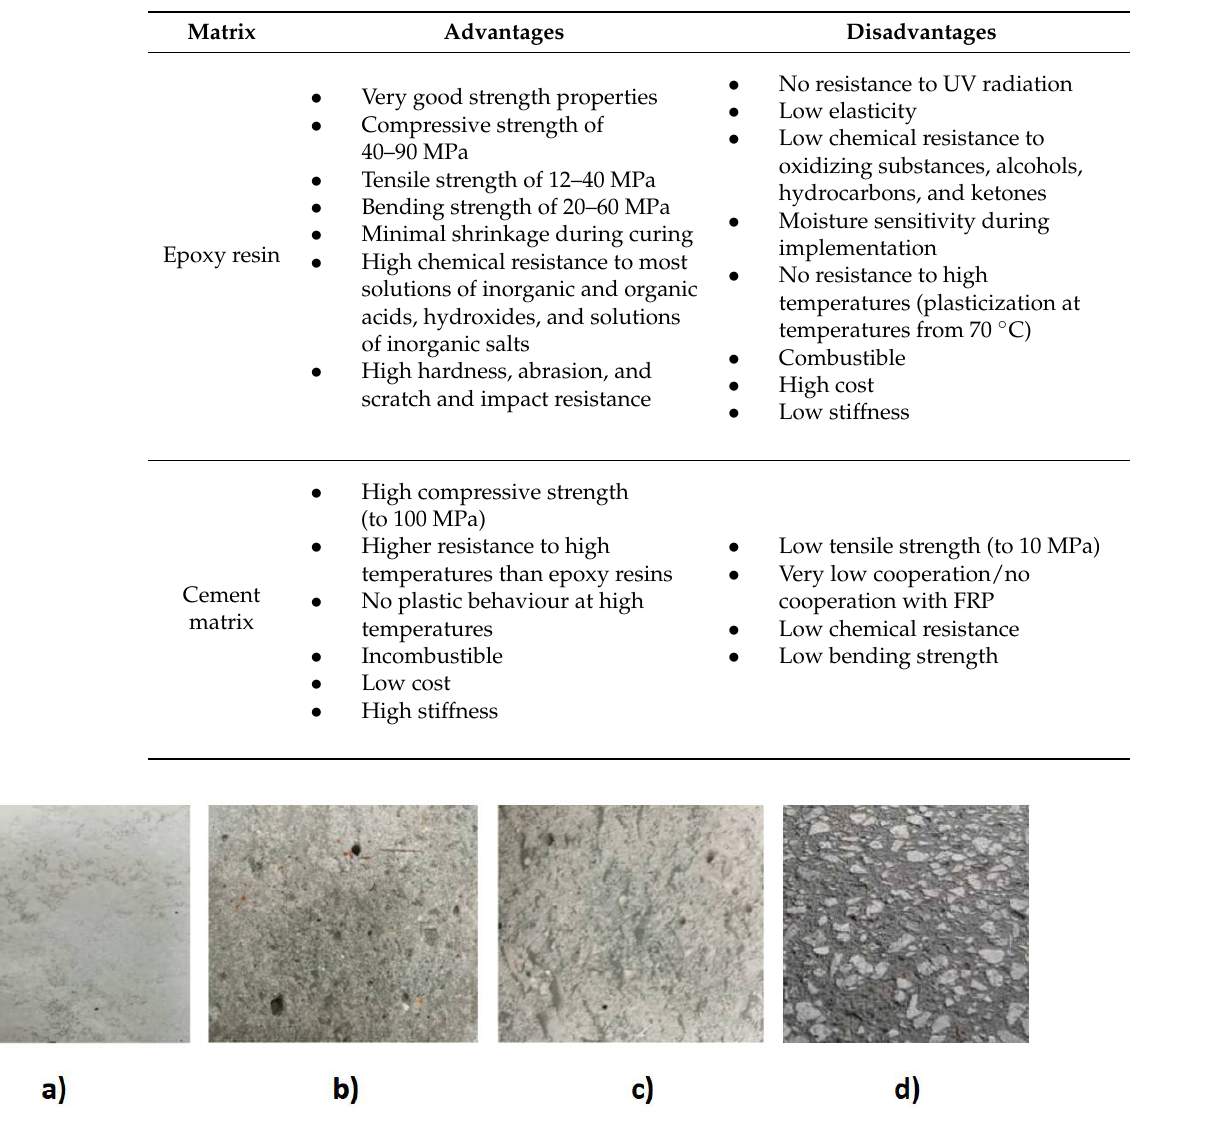
Figure 9 . Types of concrete substrate surface: ( a ) unprepared, ( b ) sanded, ( c ) grinded, and ( d ) shot